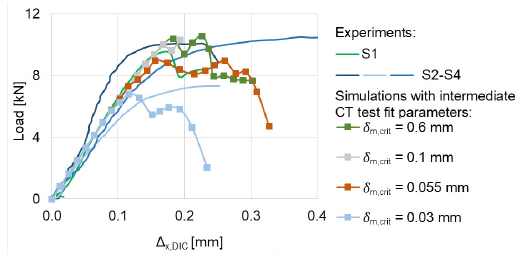
Figure 10. Load vs. DIC relative vertical displace- ment ∆ x,DIC for the results of ASTM shear test ex- periments and simulations calculated with the inter- mediate parameters from Table 2 and different values of δ m,crit .